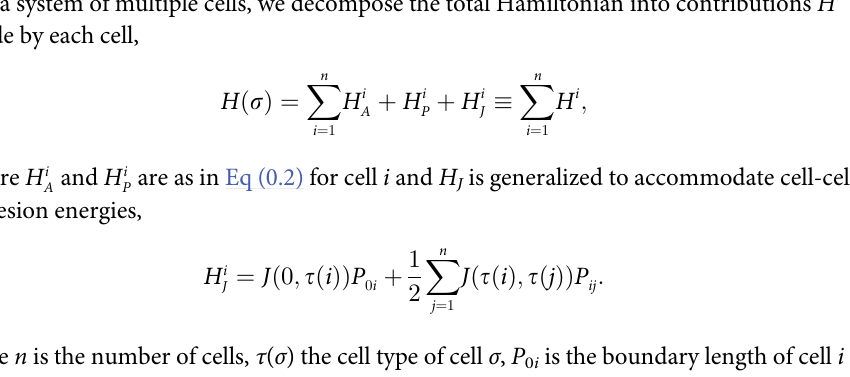
S1 Fig. Neighborhoods for perimeter calculations. Neighborhoods N ð ~ x ; r Þ of various orders with radii r = 3, 5, 10 around a lattice site ~ x (shown in red). S2 Fig. Spin flips. Examples of four possible spin flips used to compute F based on our algo- x rithm. S3 Fig. The effect of the neighborhood radius used for smoothing the cell boundary forces for ellipsoidal cells. (A) Sum of square errors (SSE) between normalized CPM force vectors and true unit normal vector ( − b cos( θ ), − a sin( θ )) to an ellipse with axes 10 and 20. The error is minimized at r = 14. (B) True normal vectors (green) to an ellipse with axis 10 and 20, com- pared to CPM forces smoothed with radius r = 3 (blue). (C) Neighborhood radii r correspond- ing to minimal SSE for ellipses with various axes lengths between 5 and 50. (D) Same as (B) but with smoothing radius r = 14. S4 Fig. Interpolation used to compute force in cell interior. Interpolation is used to compute the force at a site ~ x inside a CPM cell based on the centroid ~ x and the force predicted by the C CPM at a boundary site ~ x along the ray connecting the centroid and the given site. The ray M was determined by minimizing α in SI Eqn.